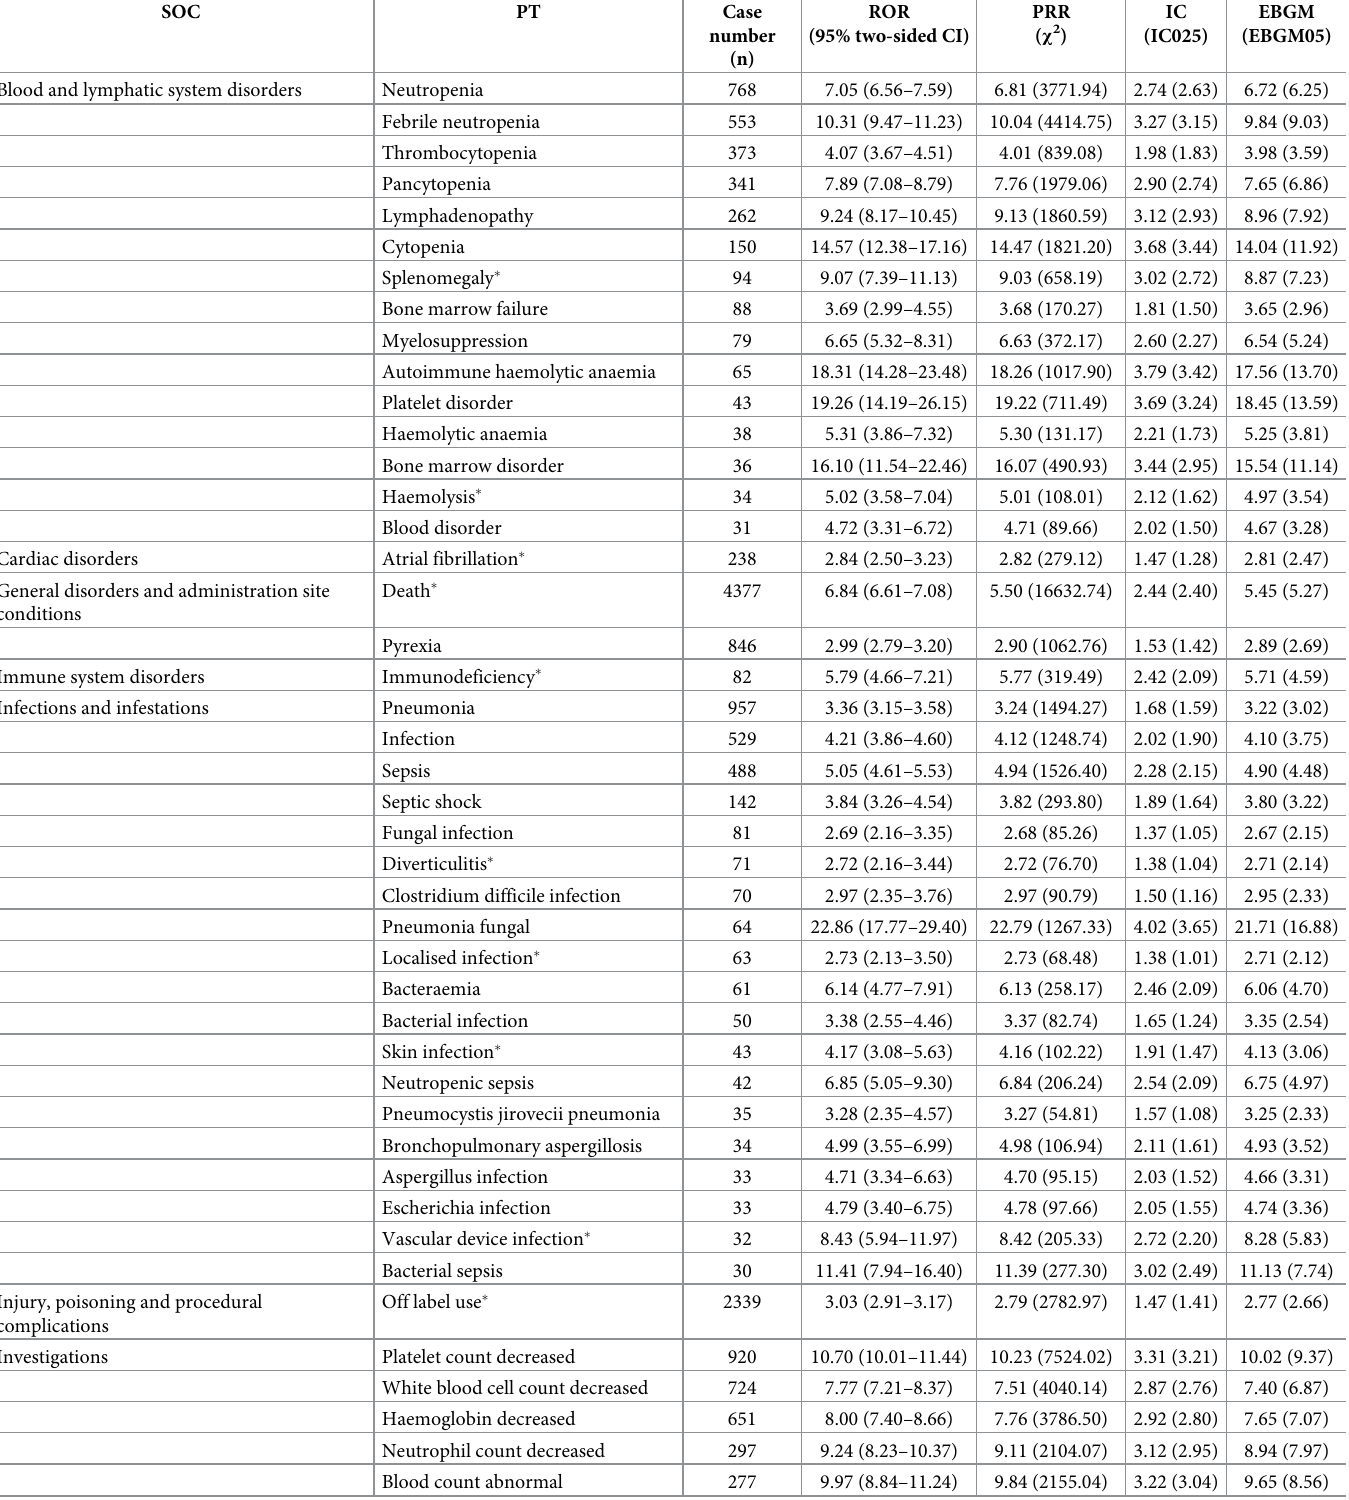
Table 3. Signal strength of AEs reports associated with venetoclax at the PT